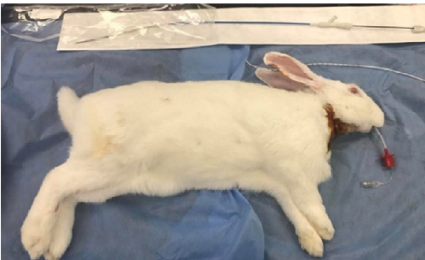
Figure 3 - Preparation of a rabbit model for stent deployment. The rabbit model was intubated with a 3-0 endotracheal tube, and the rabbit was positioned in lateral recumbency with the neck flexed.